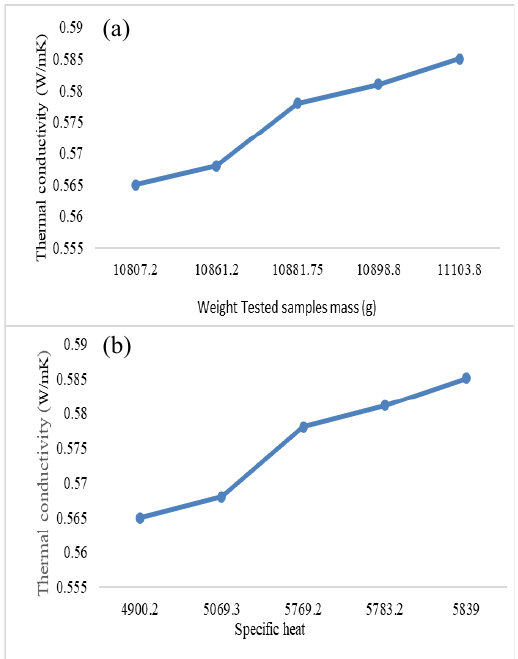
Figure 6. The variation of thermal conductivity: